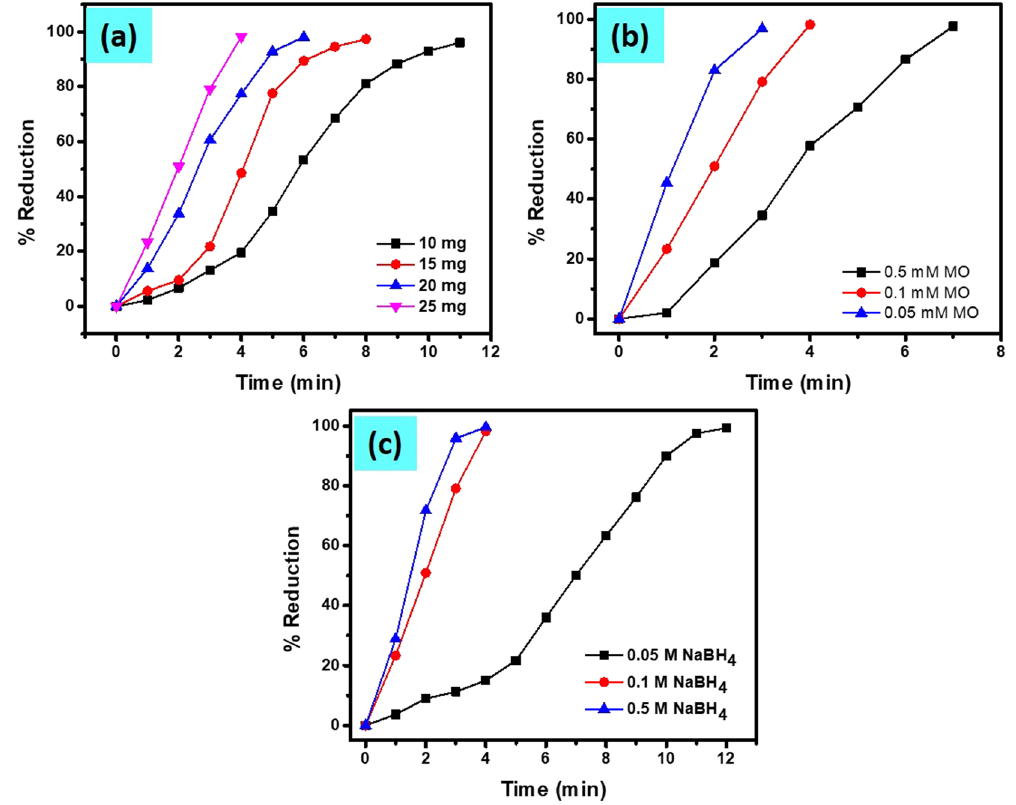
Figure 8. Percent reduction of MO dye by NaBH 4 in the presence of different catalyst amount (Cu/CS-TiO 2 -15) ( a ), different initial concentration of MO ( b ) and different initial concentration of NaBH 4 ( c